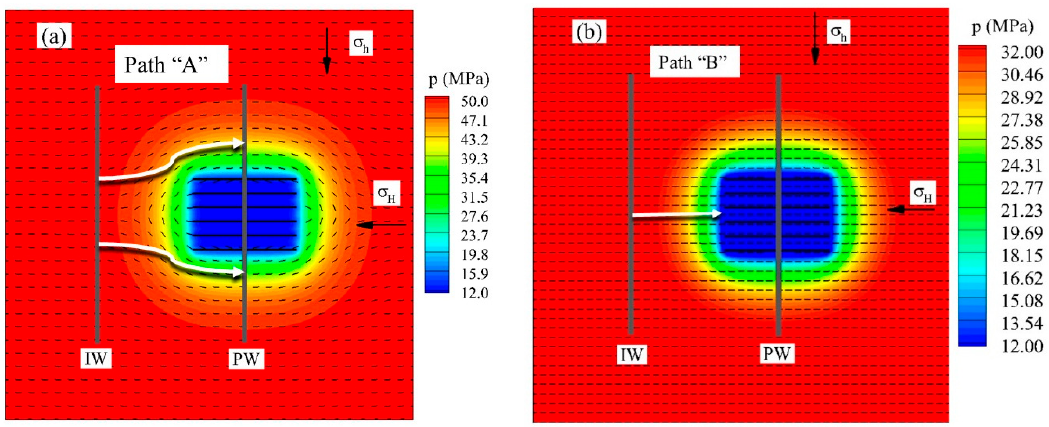
Figure 2. ( a ) Fracture-to-well interference: the infill well fractures hitting the parent well, ( b ) fracture-to-fracture interference: the infill well fractures, hitting the parent well fractures. The contour plots show reservoir pore pressure distribution after 2 years of production, and “dotted” black lines represent trajectories of the local maximum principal stress. (PW: Production well and IW: Infill well).